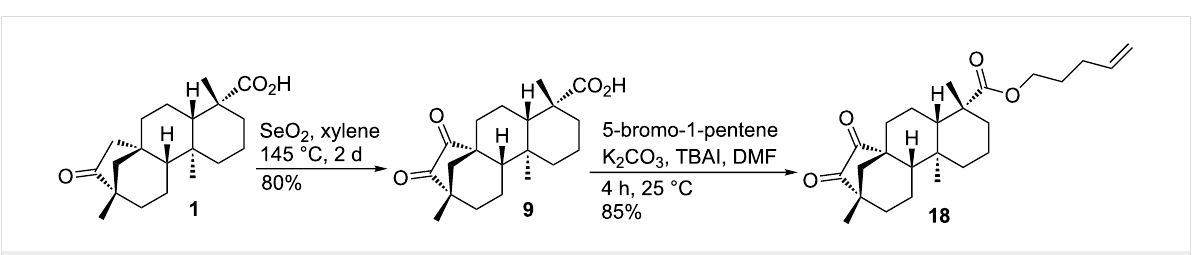
Scheme 8: Alkylation of ( − )-isosteviol diketone 9 with